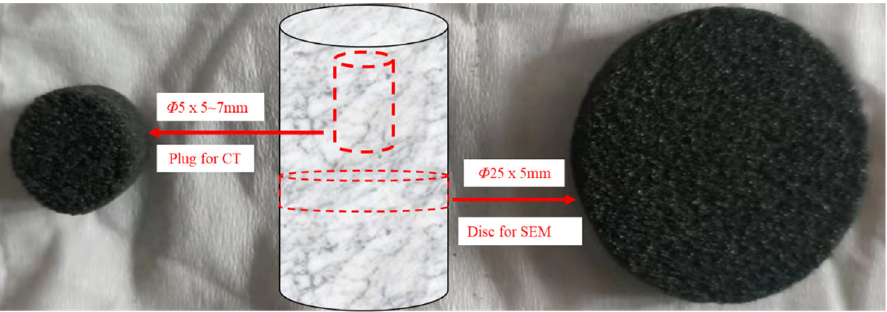
Figure 6. Sample preparation for SEM and CT